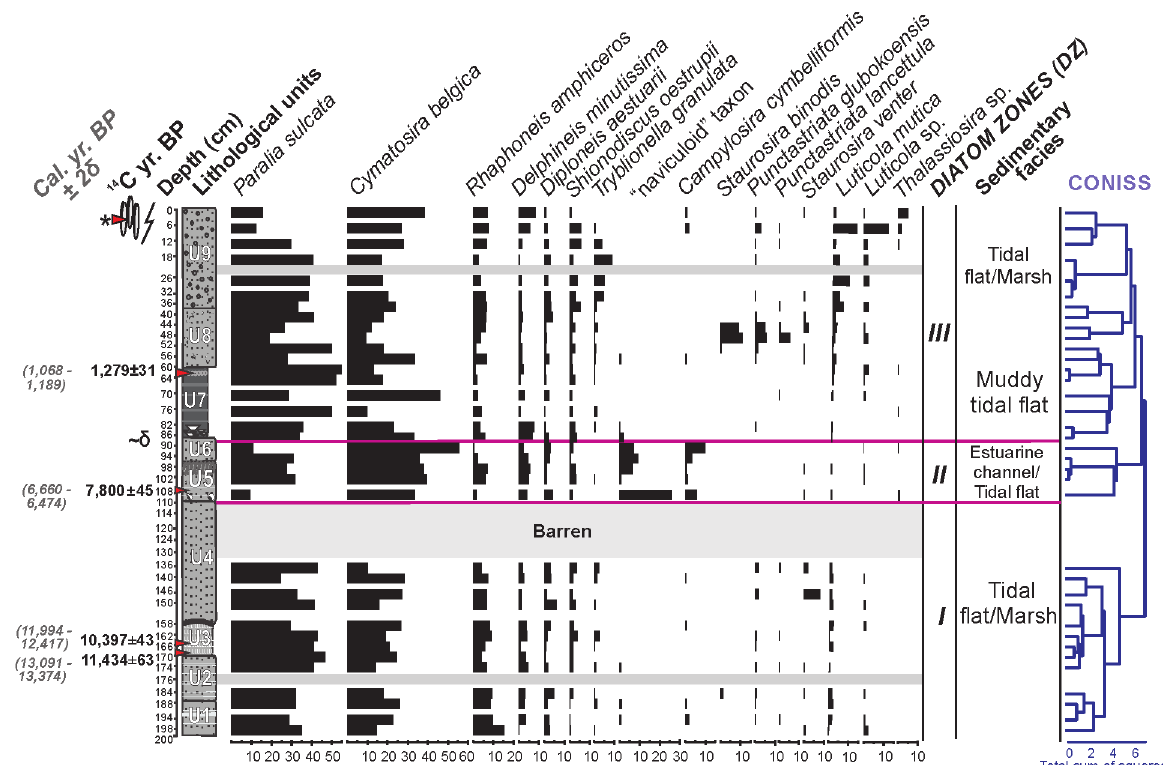
Figure 3. Relative frequencies diagram showing the most abundant diatoms taxa (> 5%) of the LCH-core and diatom zones (DZI to DZIII) obtained by CONISS (Bray Curtis distance). Sedimentary facies are based in the Ta et al. (2001)